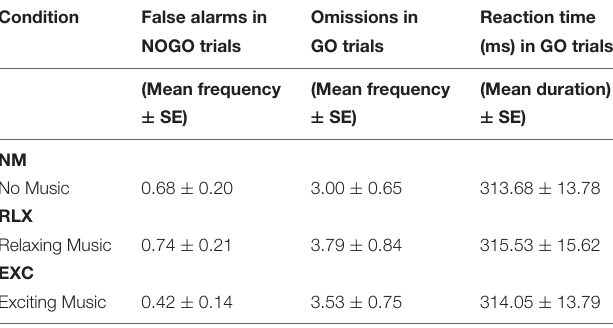
TABLE 1 | Performance data of the three